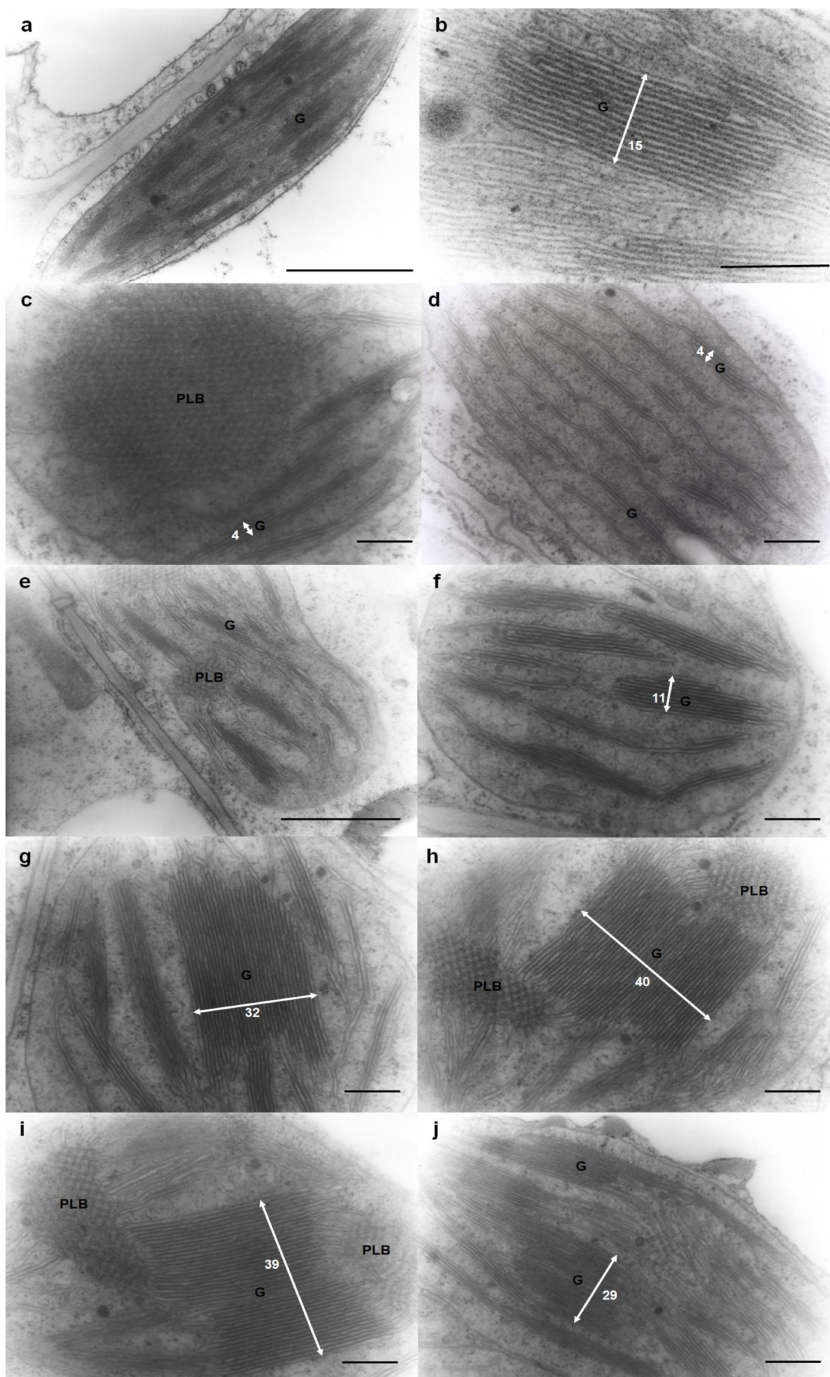
Figure 7. Ultrastructure and morphology of thylakoid membranes of mesophyll cells from newly developed leaves of Pachira macrocarpa plants fed various concentrations of glucose in complete darkness. The central part of a leaf was sampled. Panels ( a , b ) were under natural illumination conditions without glucose. Panels ( c , d ) were dark-grown control plants. Panels ( e , f ) were dark- grown plants with 2% glucose. Panels ( g , h ) were dark-grown plants with 4% glucose. Panels ( i , j ) were dark-grown plants with 6% glucose. Abbreviations: G, grana; PLBs, prolamellar bodies. Bars in ( a , e ) = 1 µ m; Bars in ( b – d , f – j ) = 200 nm. Numbers of thylakoid layers are indicated by white